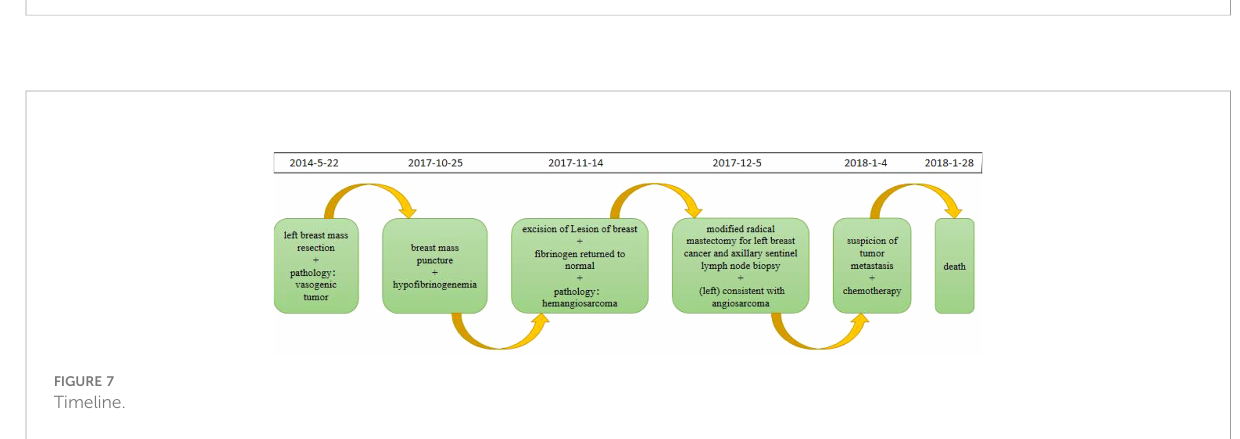
Hypo fi brinoemia Fibrinogen is a precursor of fi brin and one of the main substrates involved in the process of coagulation and hemostasis.